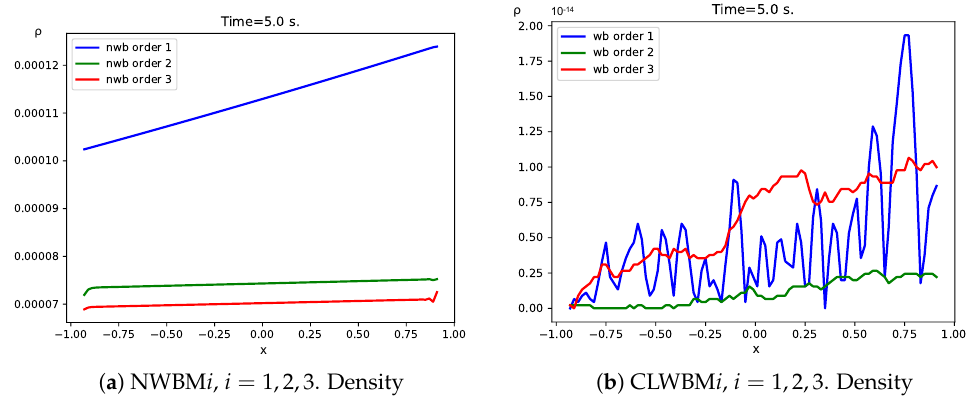
Figure 14. Test 5.1. Differences between the stationary and the numerical solutions at time t = 5 s for ρ with a mesh of 100 cells.